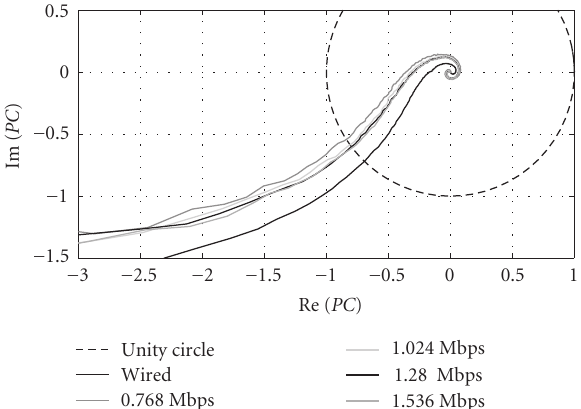
Figure 12: Nyquist plot of wired and wireless open loop transfer function PC with two consecutive packets lost.